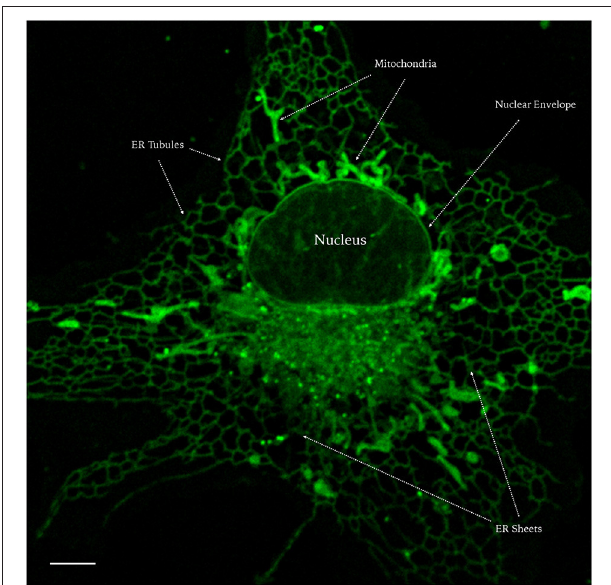
FIGURE 10 | Confocal live imaging of a LX2 cell stained with NRB-AF12 showing subcellular distribution of the fluorescent probe. Magnification 100x; scale bar 5 µ